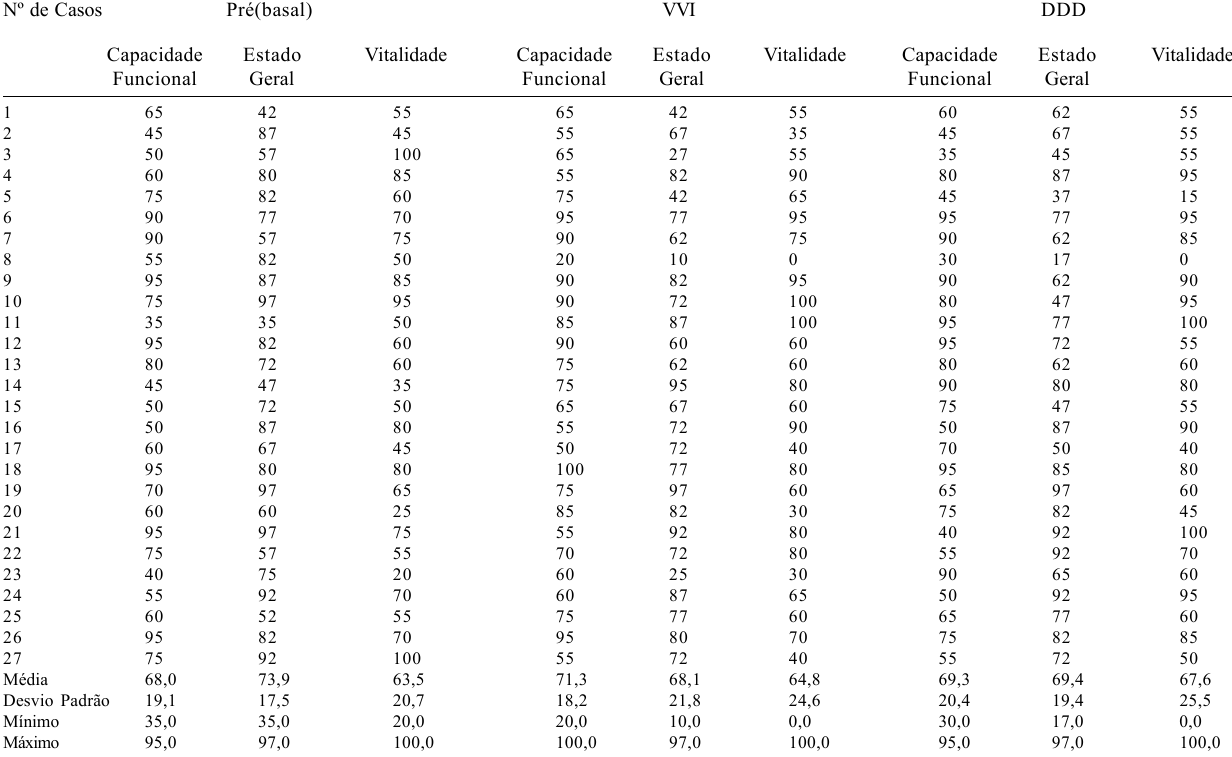
DDD: condição do paciente após 90 dias de estimulação atrioventricular; FC: freqüência cardíaca; PRÉ: condição do paciente em estimulação ventricular exclusiva na seleção do estudo; SF36: Short Form (questionário de qualidade de vida de 36 perguntas); VVI:condição do paciente após 90 dias de estimulação ventricular.